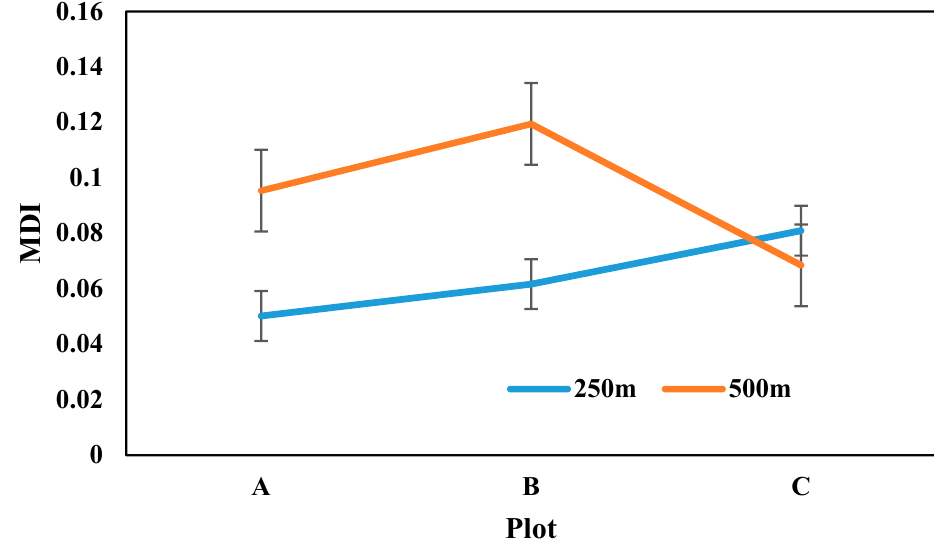
Figure 9. MDI curves of the three plots at the scales of 250 m and 500 m.